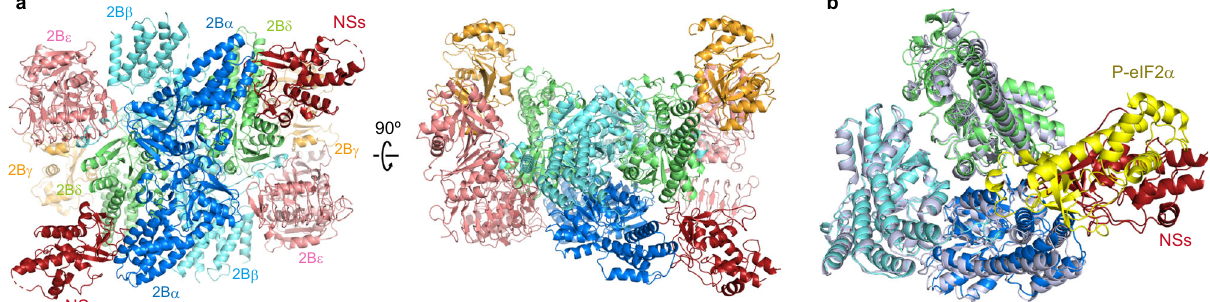
Fig. 1 Cryo-EM structure of the human eIF2B SFSV NSs complex. a Overall structure of the human eIF2B • SFSV NSs complex (eIF2B α : blue; eIF2B β : cyan; eIF2B γ : orange; eIF2B δ : lime; eIF2B ε : pink; SFSV NSs: maroon). b Overlay showing a comparison of the interactions through the α - δ groove of eIF2B in the eIF2B • SFSV NSs complex and in the eIF2B • eIF2( α P) complex (PDB: 7D44) 14 . The eIF2B subunits and the phosphorylated eIF2 α subunit in the eIF2B • eIF2( α P) complex are pale blue and yellow, respectively. The two structures are aligned with their eIF2B β subunit C-terminal